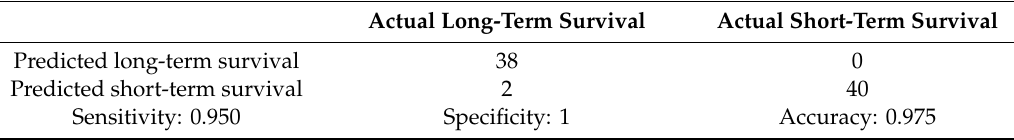
Figure 6. The final overall prognostic model in UM. ( A – C ) The process of building the signature containing all survival-related AS events and the coefficients calculated by LASSO method: ( A ) Partial likelihood distribution with the corresponding λ-logarithm value and the left variants of model ( B ) LASSO coefficient profiles of all survival-related alternative splicing (AS) events. A vertical line is drawn at the value chosen by 10-fold cross-validation. ( C ) The distribution of risk score, overall survival (OS) and life status for the 80 patients in UM. ( D ) Kaplan–Meier overall survival curves of the final prognostic model. Time-dependent numbers at risk are listed at the middle panel and the number of censor patients are listed at the bottom panel. ( E ) The ROC curves of predictive model for all splicing types in UM. ( F ) The expression values of 11 spliced genes in UM and healthy normal tissue (** p < 0.01, ns means no significance). Table 1. The confusion matrix of the predicted and actual sample